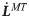
Diagram of a neural controller.(A) This NC model, proposed in a previous study [36], consists of FF and FB control. u, ufb, and uff are the total, FB, and FF controls, respectively. a denotes muscle activation. LMT and L˙MT are the length and lengthening velocity of the muscular-tendon actuators, respectively. L0MT and L˙0MT are the initial values of the length and lengthening velocity of the muscular-tendon actuators (L˙0MT=L¨0MT=0), respectively. LM and L˙M are the length and lengthening velocity of muscle fibers, respectively. (B) FB control is implemented as PD controllers using proprioceptive information (muscle length and lengthening velocity). kp and kd are PD gains.